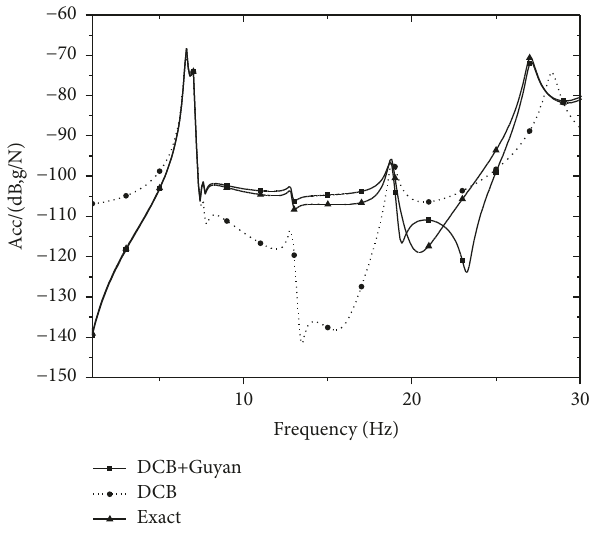
Figure 6: Acceleration FRF comparison, H(5,2).